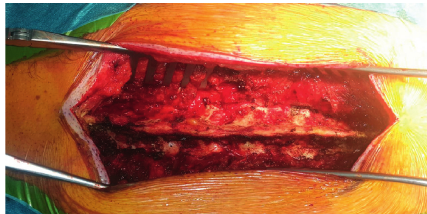
Figure 3: Intraoperative image showing the thickened epidural fat before